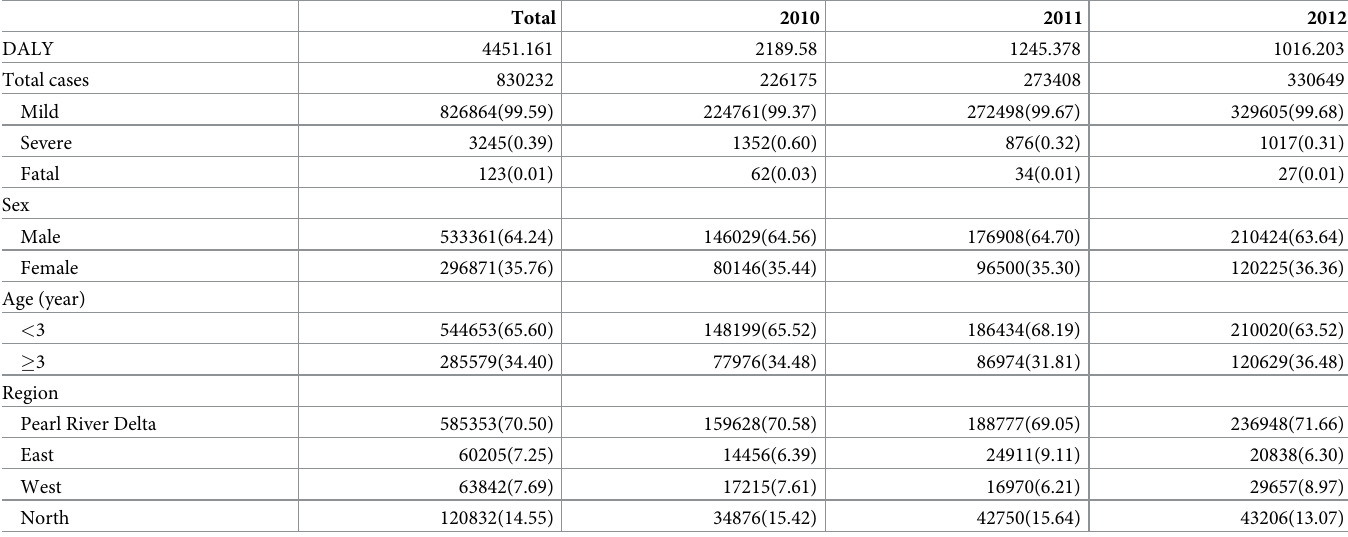
Table 1. Basic features of HFMD in Guangdong,